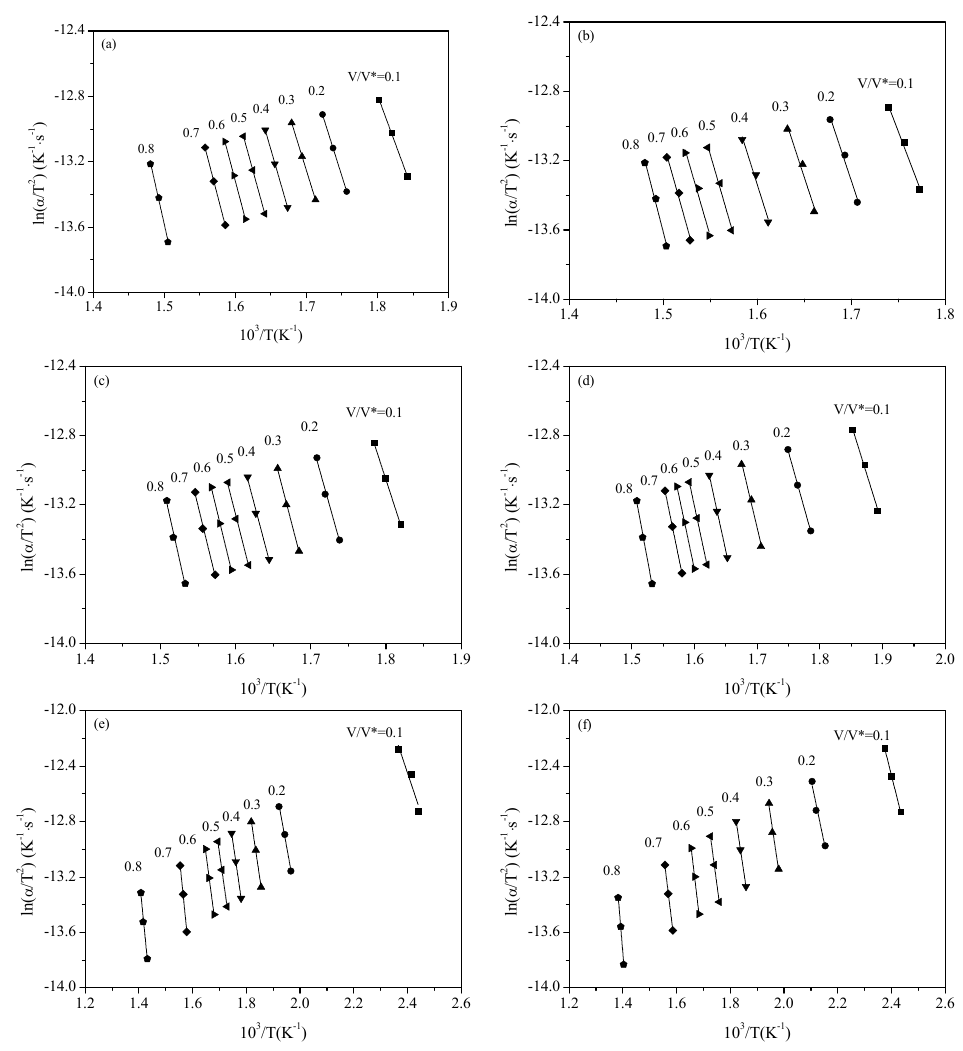
Figure 2. Arrhenius plots of α /T 2 vs. 1/ T at selected V/V * values. ( a ) Rice straw (RS); ( b ) RS ‐ H 2 O; ( c ) RS ‐ HCl; ( d ) RS ‐ KCl; ( e ) RS ‐ CaCl 2 ; ( f ) RS ‐ MgCl 2 .